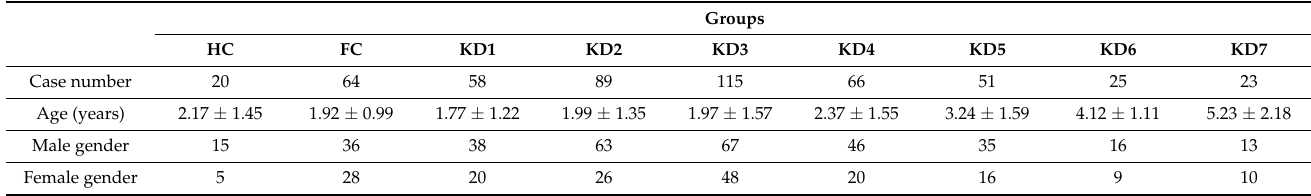
Table 1. Basic information in different groups.